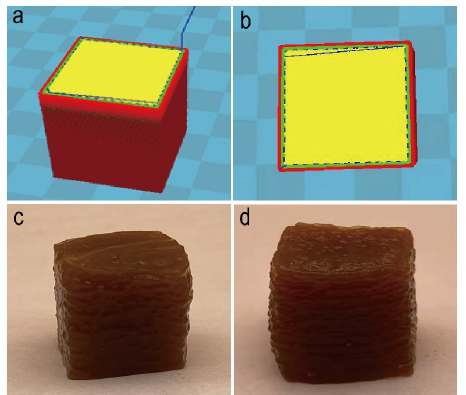
Figure 3. Three-dimensional food printing of the CFJ. ( a ) Three-dimensional printed shape of the 15 × 15 × 15 mm cube, designed with Cura15.02.1 software. ( b ) Cross-sectional view of the 3D shape. The yellow part is the print infill part, and the middle slash indicates the infill patterns of the CFJ. ( c ) Three-dimensional printed cubic jelly obtained with an infill velocity of 10 (mm/s) with an infill density of 100%. ( d ) Three-dimensional printed cubic jelly obtained with an infill velocity of 15 (mm/s) with an infill density of 90%.